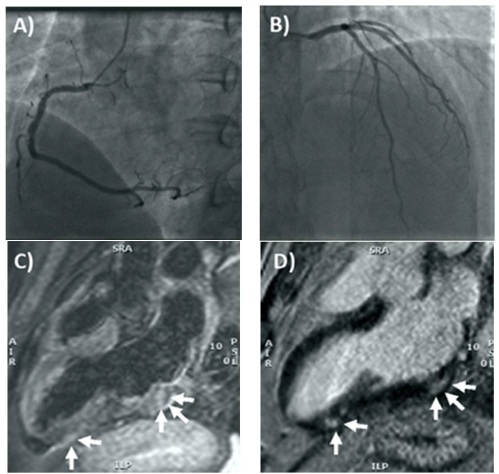
Figure 1. Coronary angiography and cardiac MRI. ( A ) The right coronary artery only had a mild plaque (<30% luminal diameter) in the mid portion, whereas in ( B ) the left main stem, left anterior descending artery, and circumflex artery had no evidence of coronary plaques. ( C ) T2-weighted 3-chamber view on cardiac MRI, showing focal areas of edema involving the subepicardi- al-intramyocardial regions of the basal and apical segments of the inferolateral wall (arrows). ( D ) Late gadolinium enhancement confirmed the presence of non-ischemic myocardial lesions in the basal and apical segments of the inferolateral wall (arrows) consistent with acute myocarditis. Reprinted/adapted with permission from Ref. [13] 2021, Elsevier. Figure 2. Cardiac MRI PSIR-LGE views show late gadolinium subepicardial enhancement in basal lateral segments in ( a ) four-chamber and ( b ) short-axis views. Reprinted/adapted with permission from Ref. [14]. 2021, Elsevier.